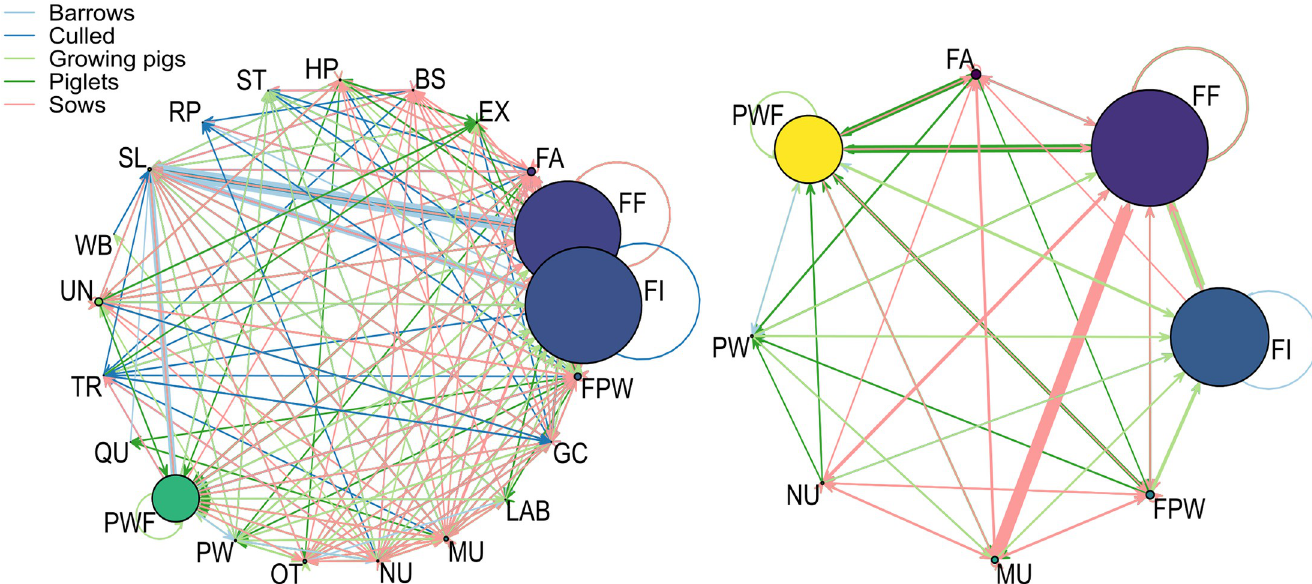
Fig 1. Aggregated and directed French swine networks. Number of animals exchanged between the different actors of the swine production by type of animal: total network (left), between-farm network (right). Colors of the arrows correspond to different type of animal, thickness of the arrows corresponds to the amount of animals. Colours of the circles correspond to different type of holdings and their size corresponds to the relative number of farms of that type. BS: boar station, EX: exposition (zoo, ... ), FA: farrowers, FF: farrowers-to-finishers, FI: finishers, FPW: farrowers-post-weaners, GC: gathering center, HP: hobby pigs, LAB: laboratory, MU: multipliers, NU: nucleus, OT: other, PW: post-weaners, PWF: post-weaners-finishers, QU: Quarantine center, RP: rendering plant, SL: slaughterhouse, ST: Stopping point, TR: trader, UN: unknown, WB: wild boar.